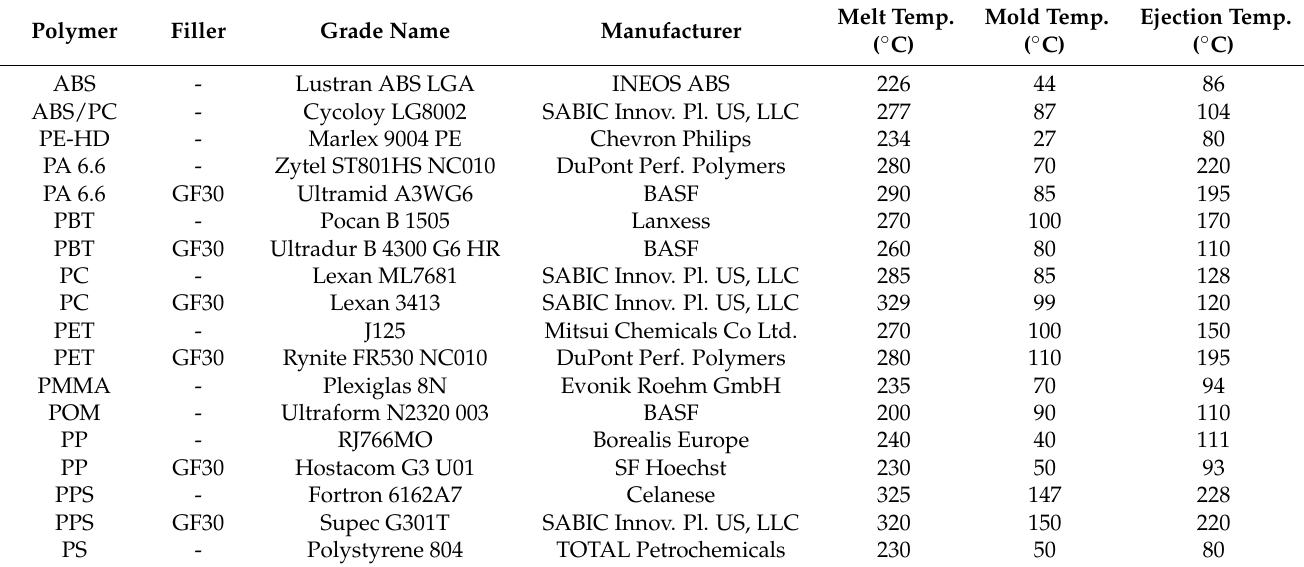
Table 2. Investigated polymers with filler content (GF30 = 30 wt.% glass fiber) and recommended processing temperatures (according to Moldflow material data base in the software version